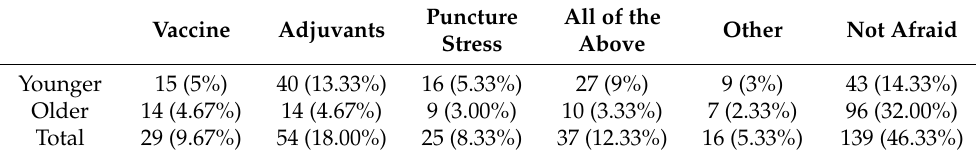
Table 2. Reasons for fear of vaccination.